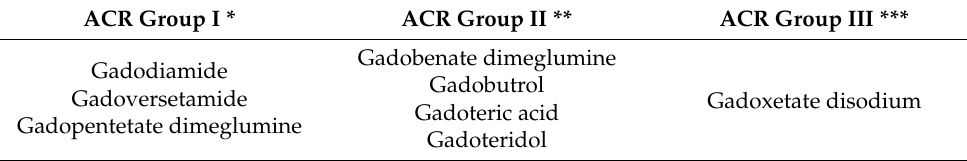
Table 3. ACR Manual Classification of Gadolinium-Based Agents Relative to NSF †